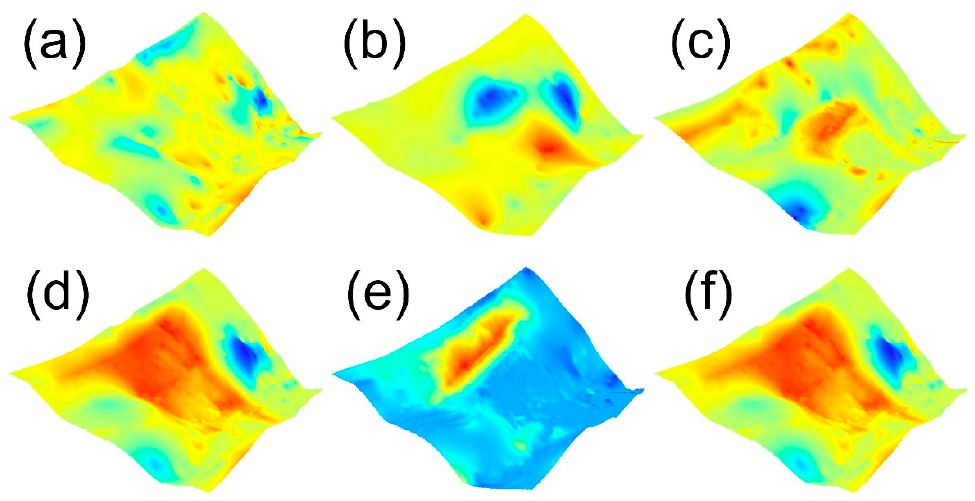
Figure 8. 3D model of the earthwork sections at each stage. ( a ) constructing an access road to the lower part of the embankment and the formation of the base, ( b ) forming the embankment base by earthwork and logs, ( c ) forming the lower part of the embankment by earthwork and logs, ( d ) forming the upper part of the embankment by earthwork and logs, ( e ) shaping the entire embankment, ( f ) overall earthwork.